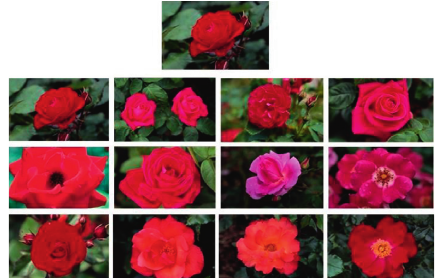
Figure 14: Retrieval of top 12 images as a result of search image selected from flower